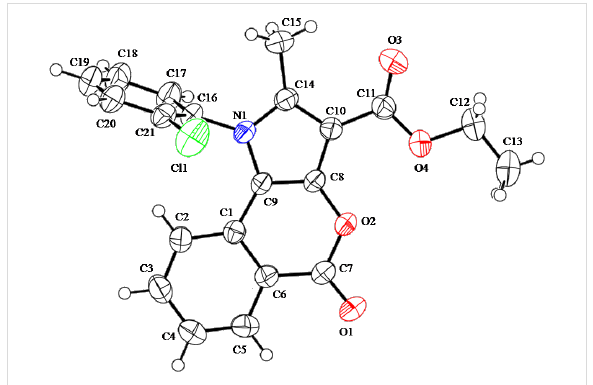
Figure 1: ORTEP diagram of 8c with atom numbering scheme. Thermal ellipsoids are shown at 50% probability with CCDC number